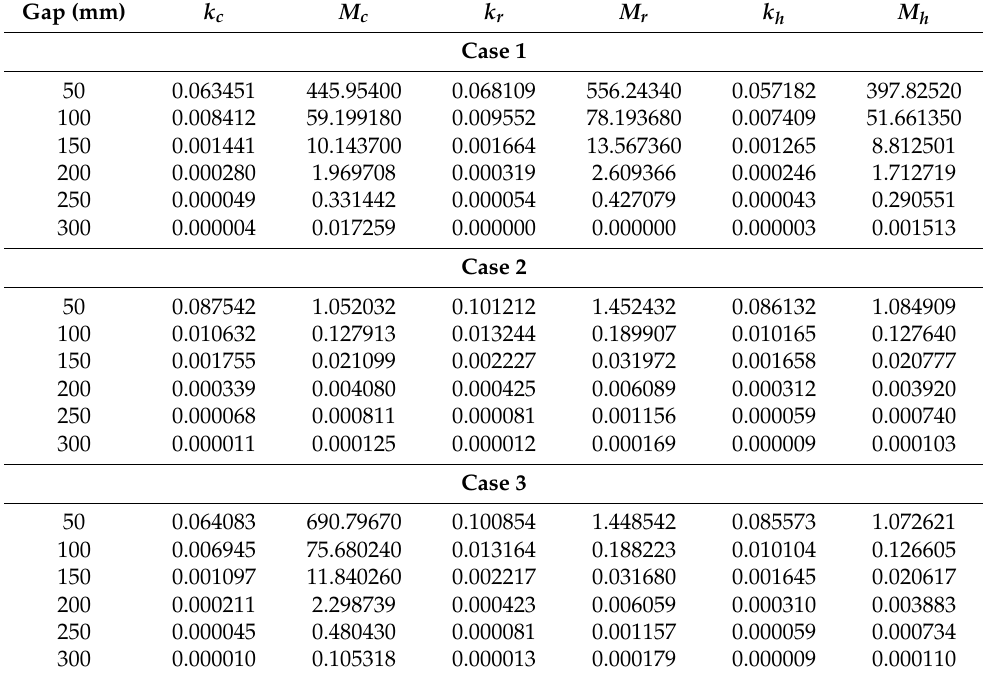
Table 11. The simulation results ( k , M ) of the three geometries: case 1, case 2, and case 3. Gap (mm) k c M